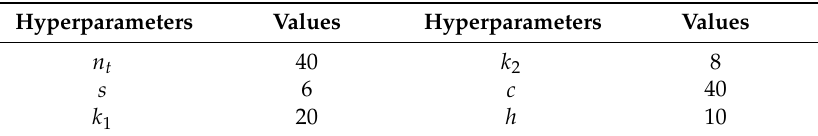
Table 9. Hyperparameters of the virtual sensor model for response prediction of simply supported beam experiment.